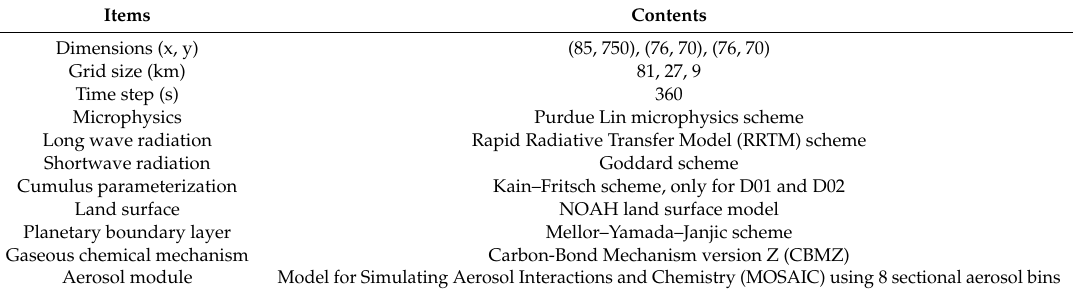
Table 1. The grid setting, physics, and chemistry options used in WRF-Chem